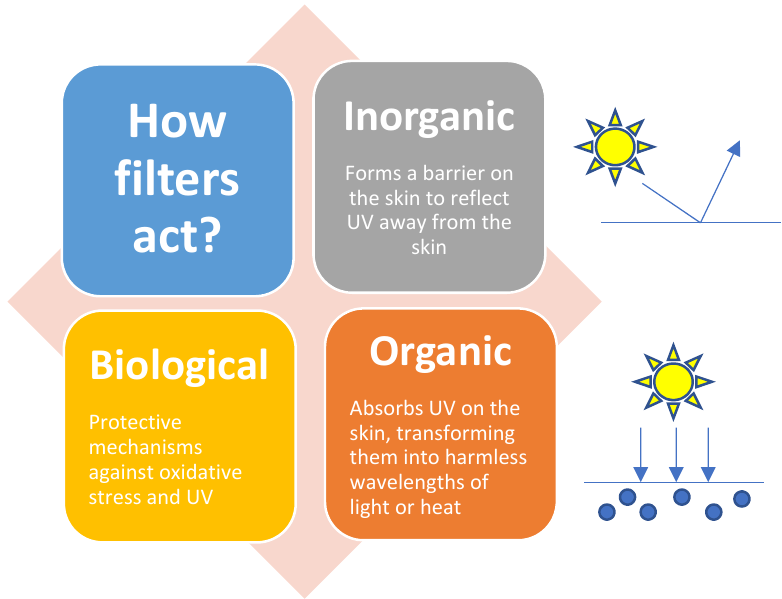
Figure 1. Type of filters and its mechanism of action. Table 1. The most used organic filters and their possible risks (based on EWG classification). UVB Filters/Risks